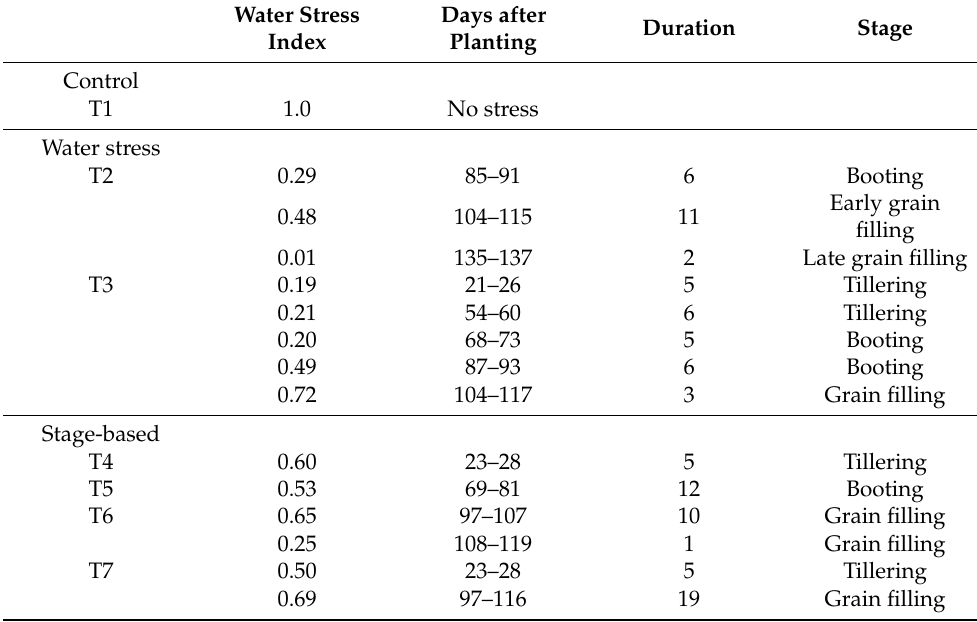
Table 9. Water stress index under the studied deficit irrigation